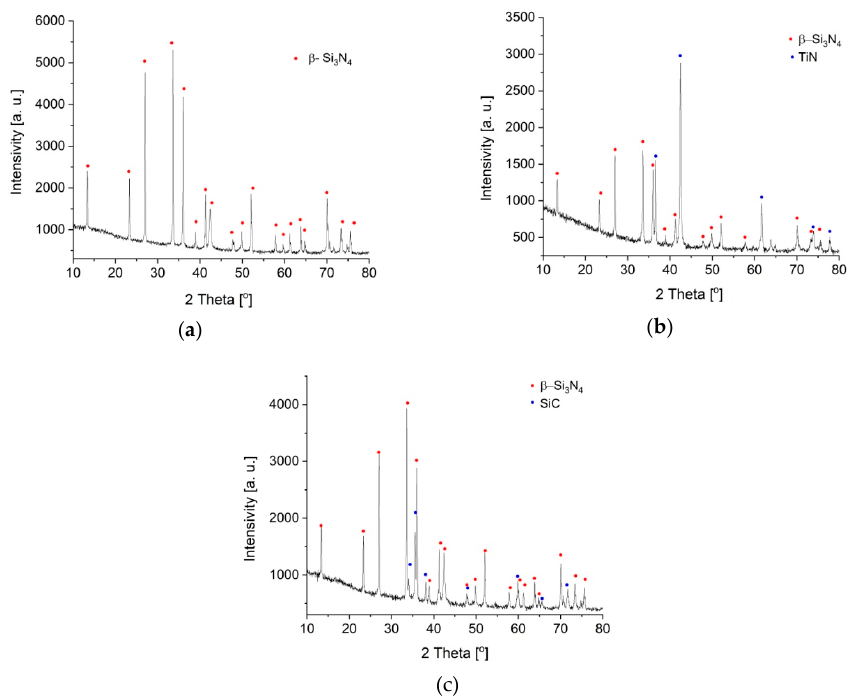
Figure 2. XRD patterns: ( a ) Si 3 N 4 , ( b ) Si 3 N 4 + 20 vol % SiC, and ( c ) Si 3 N 4 + 20 vol % TiN.